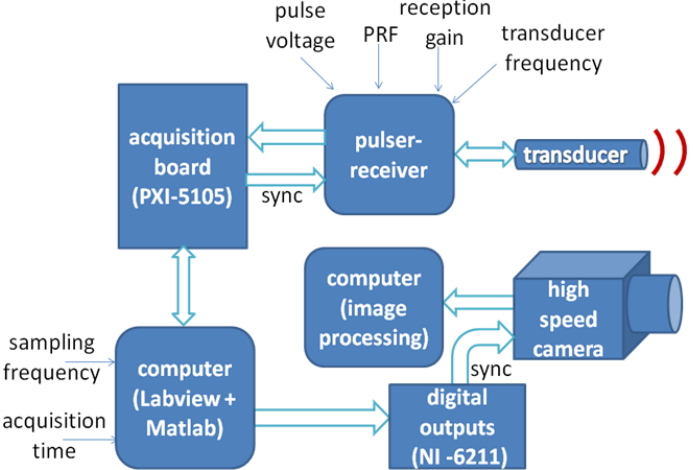
Figure 6. Block diagram of the measurement system developed to implement VMS